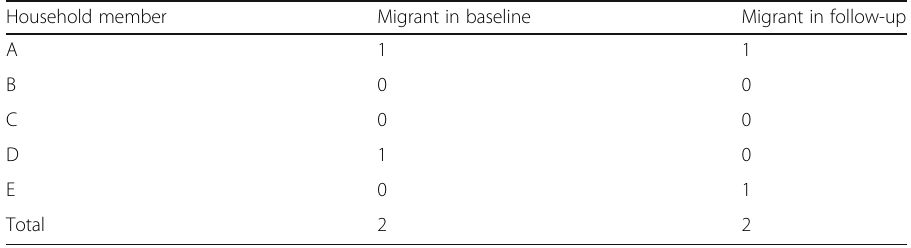
Table 1 Example household with baseline and new